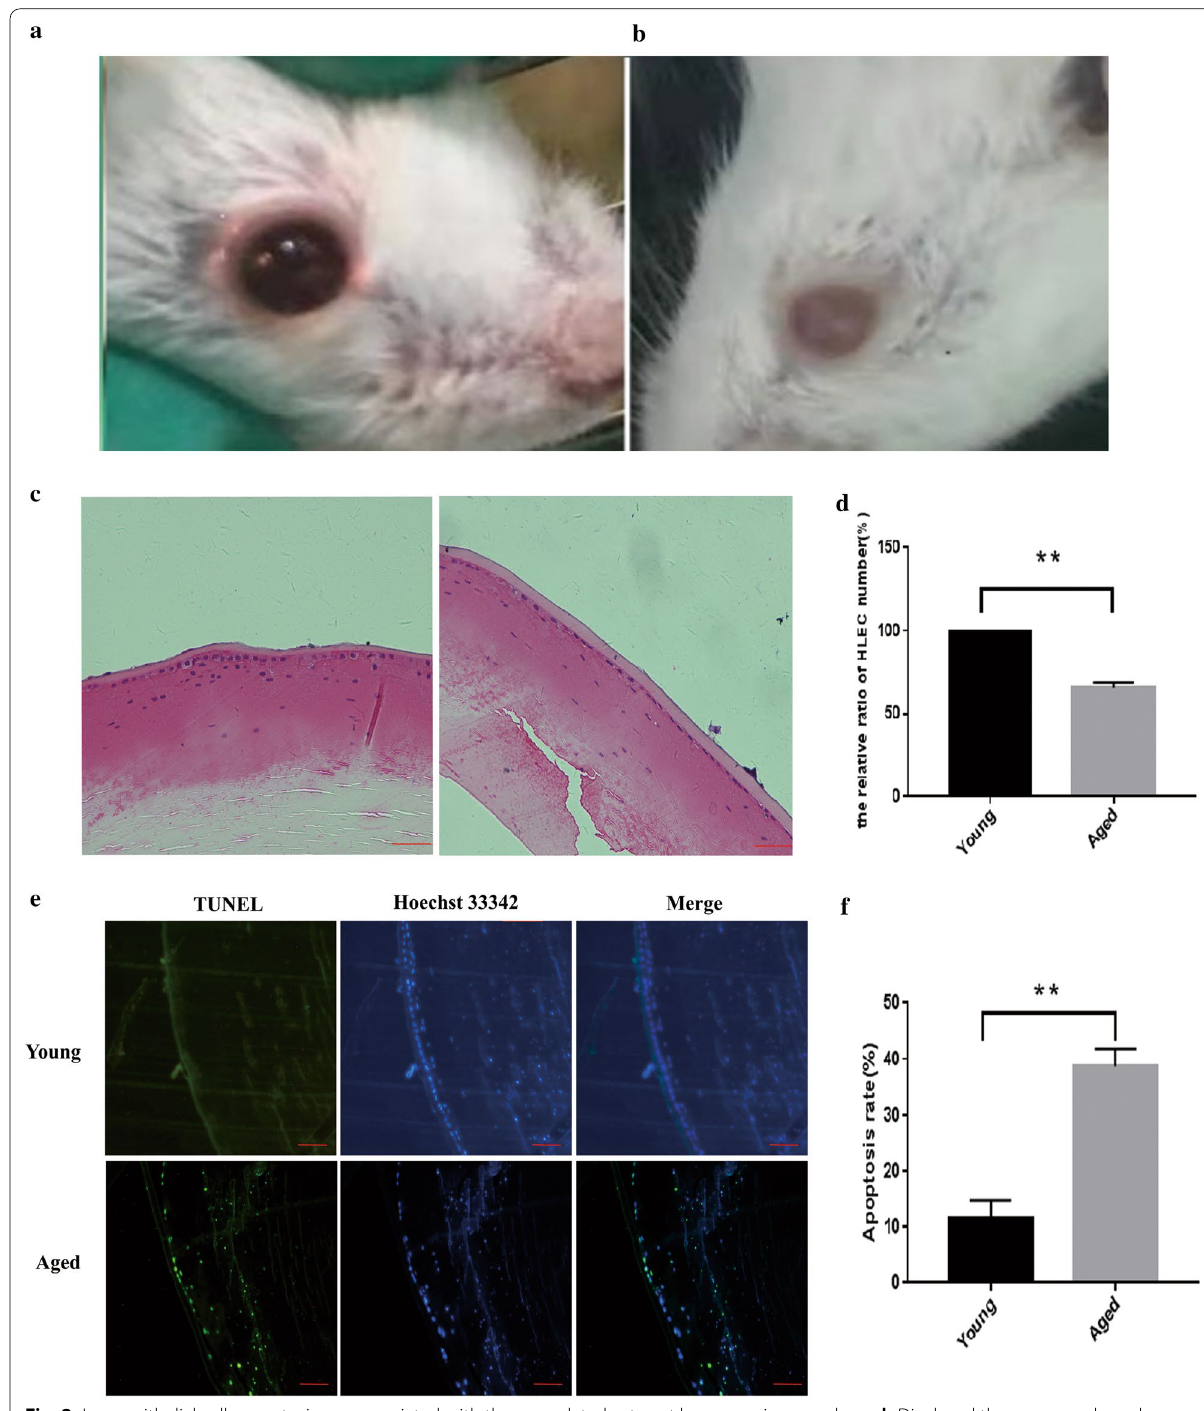
Fig. 2 Lens epithelial cells apoptosis was associated with the age-related cataract base on mice samples. a , b Displayed the young and aged eye photos respectively. The eyes of the young (3 months) mice remained clear, while, the natural aging mice displayed obvious cataracts over 24 months, and the eyes photos were taken. c A comparison of the lens epithelial cells between the old and young mice. The LECs stained with eosin, nuclei stained with hematoxylin was shown in blue. Scale bar: 20 µm. d Decreases in mouse LECs density from the old mice compared to the young mice using HE staining of whole lenses. The cell density was determined by counting nuclei stained with the hematoxylin in 5 randomly selected fields from three experiments and are shown as means SD. **p < 0.01 versus the young LECs. e Apoptotic LECs increased in old mice by ± positive TUNEL and Hoechst 33342 staining. Scale bar: 100 µm. f Counting both positive TUNEL and Hoechst 33342 cells in 5 randomly selected fields from three experiments and are shown as means SD. **p < 0.01 versus the young ±